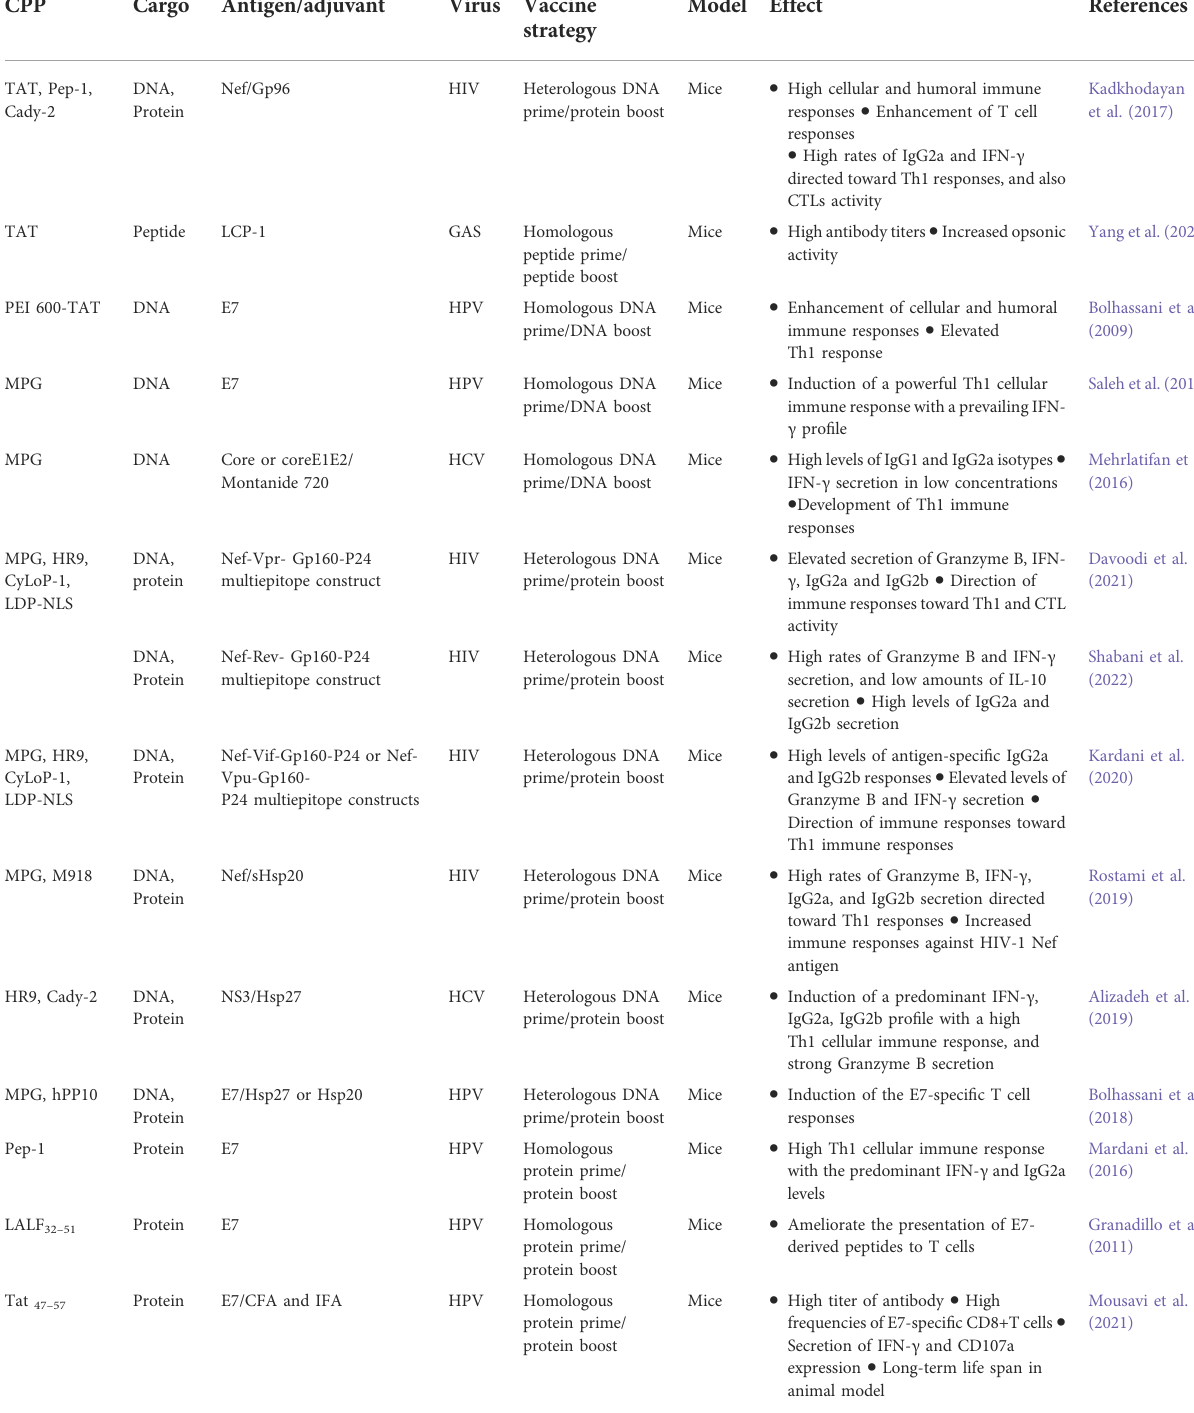
TABLE 1 Examples of different CPP-conjugated vaccines against viral